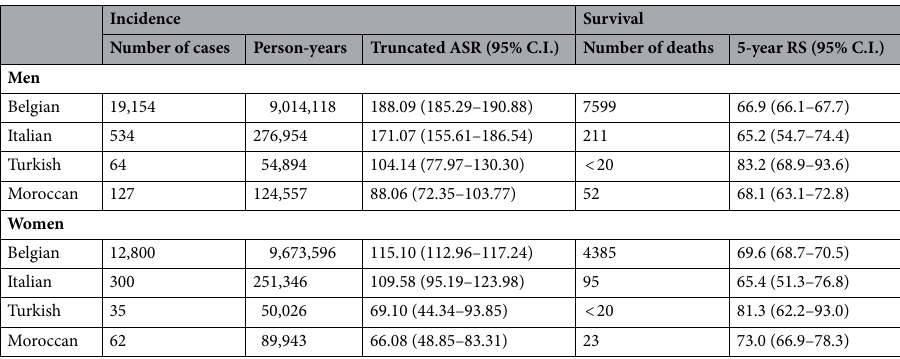
Table 3. Number of cases, person-years, truncated age-standardized incidence rates (ASR per 100,000 person- years including 95% Confidence intervals [95% C.I.]), number of deaths among cases and 5-year relative survival (RS including 95% C.I.) among the study population aged 50 to 74 years, by gender and migrant origin, Belgium, 2004–2013. Because of confidentiality issues, the exact number of cases are not reported when below